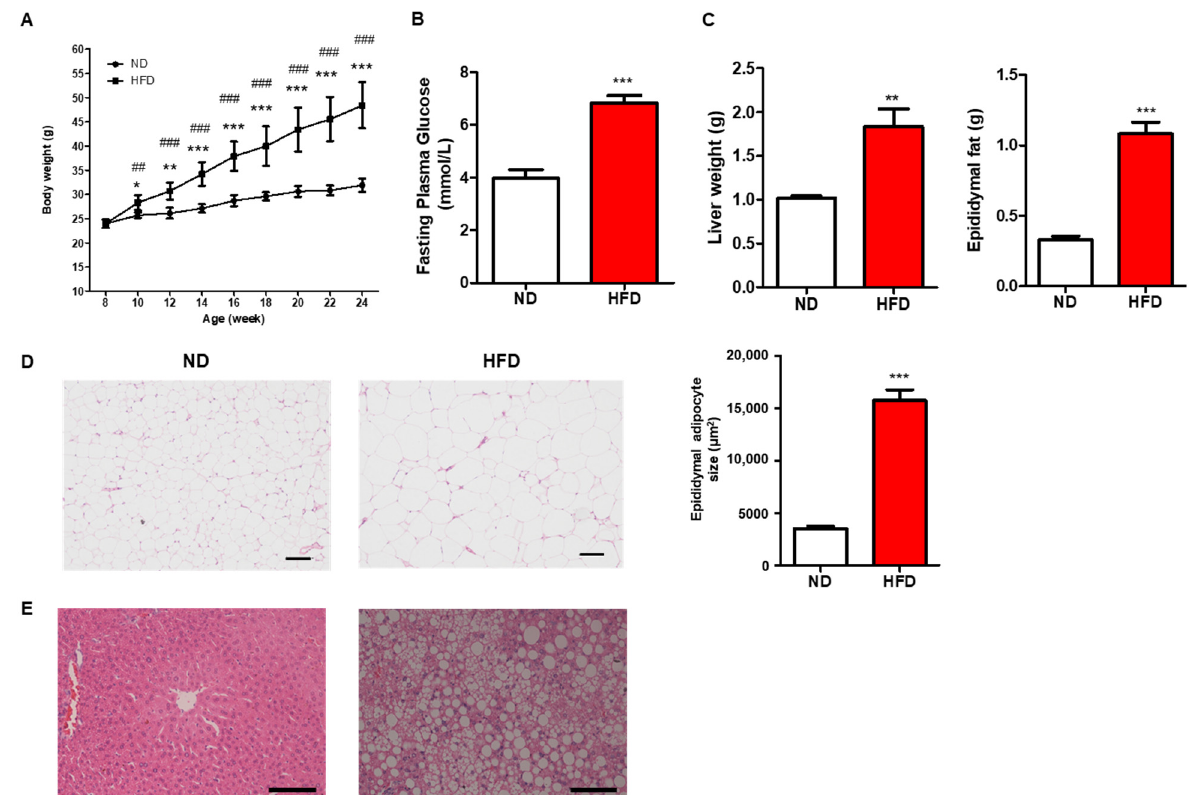
Figure 1. Effect of long-term HFD consumption on metabolic parameters. Body weight ( A ), fasting blood glucose ( B ), liver weight and white fat weight ( C ), adipocyte size of white fat ( D ), and hepatic steatosis ( E ). Values are shown as the mean ± SEM. One-way ANOVA with a post hoc Tukey test or t -test was performed. * p < 0.05; ** p < 0.01; *** p < 0.001 vs. ND, ## p < 0.01; ### p < 0.001 vs. age 8. Bar: 100 μ m.